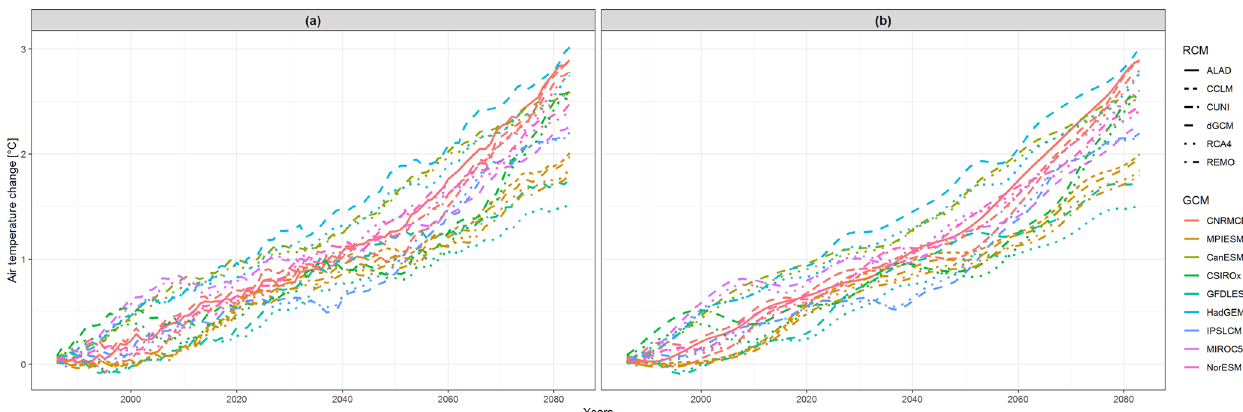
Figure 1. (a) Temporal development of running 30-year mean changes in winter (DJF) mean air temperature (changes of running 30-year mean averages throughout the period 1971–2098 in comparison to the reference period 1971–2000) averaged over the British Isles region. (b) Smoothed functional data from (a) , created as described in Sect. 3. The lines in both panels are colored according to the driving global climate model (GCM), and the type of line corresponds to regional climate model (RCM). The acronyms of the model simulations are explained in Sect. 2; dGCM stands for the driving global climate model simulation.